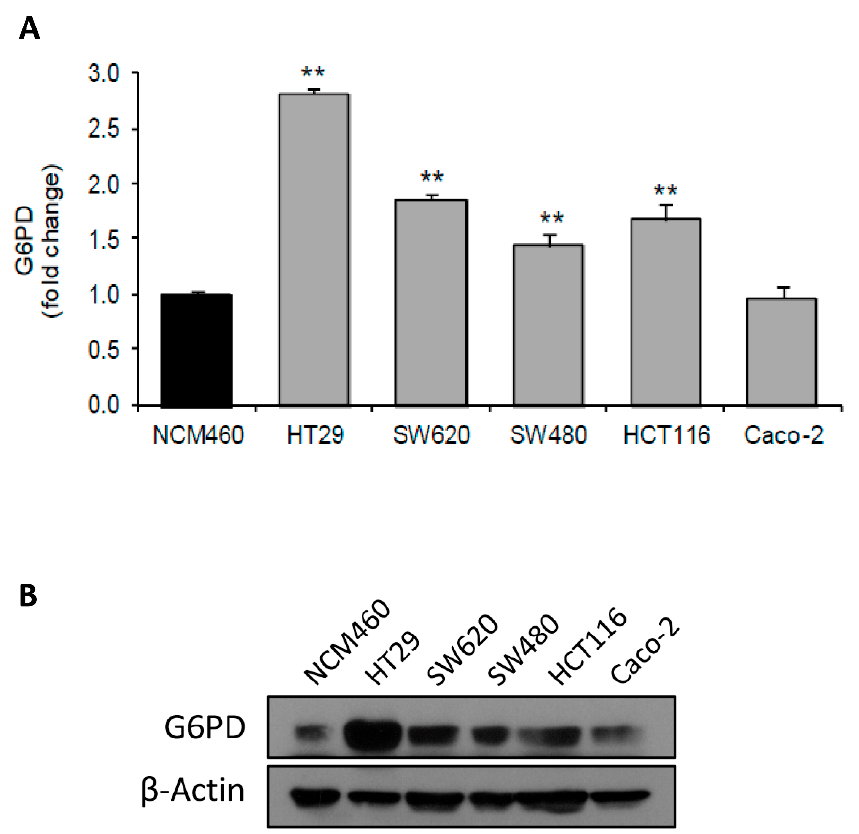
Figure 1. Colon cancer cells have greater glucose-6-phosphate dehydrogenase (G6PD) specific activity than epithelial cells derived from healthy colon mucosa. ( A ) G6PD specific activity and ( B ) protein levels in a panel of colon cancer cell lines. Enzyme activity results are expressed as a percentage of G6PD activity with respect to non-tumor colon cell line NCM460. Two asterisks (**) denote p -value < 0.01.